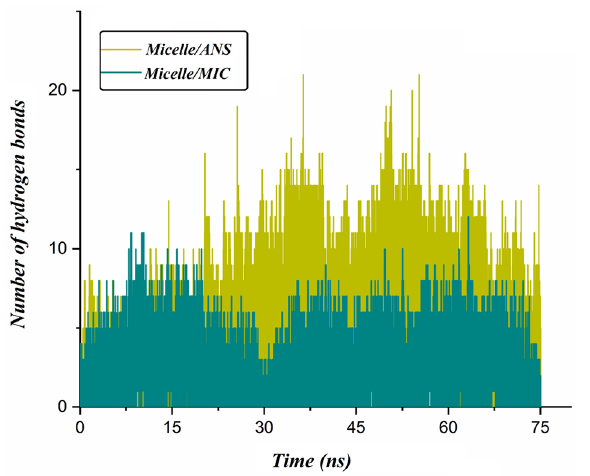
Figure 10. The number of hydrogen bonds between micelle and drug molecules as a function of time.